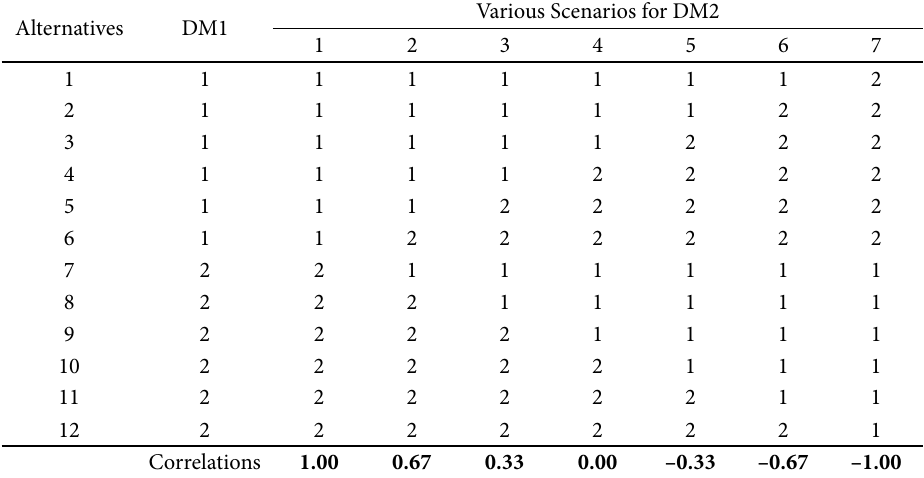
Various Scenarios for